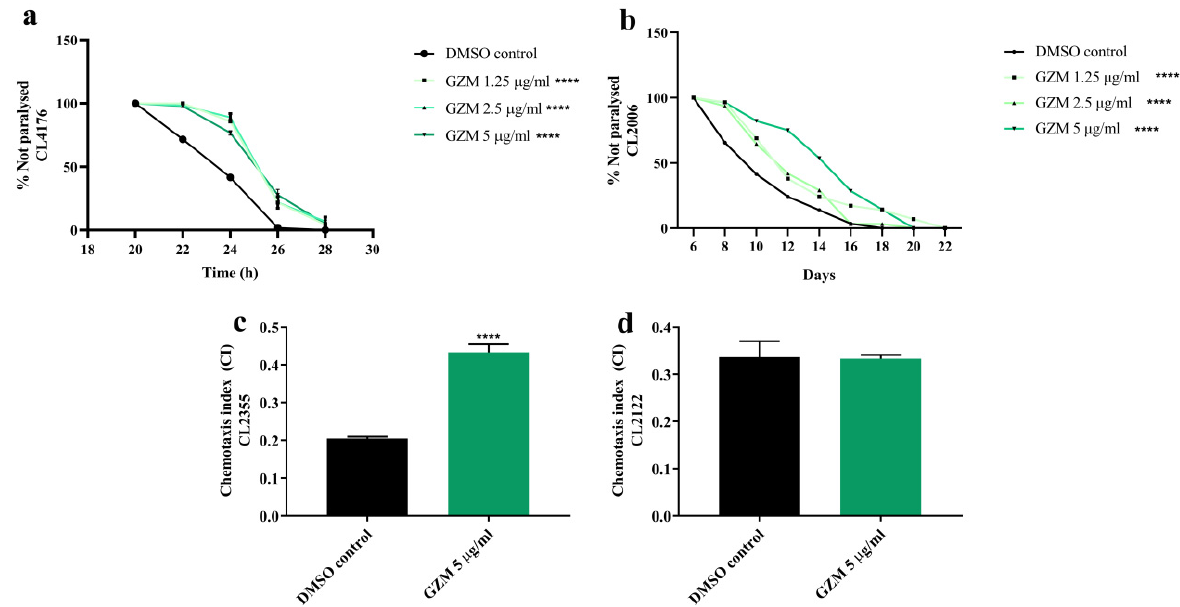
Figure 7. Neuroprotective effect of GZM extract against A β -induced toxicity in C. elegans . GZM extract delayed the progression of body paralysis in CL4176 ( a ) and CL2006 ( b ) worms. GZM extract increased the chemotaxis index in CL2355 ( c ) nematodes. The CL2122 strain serves as control strain ( d ). The represented times are from the instigation of temperature increase. The details of statistical values are provided in Table S8 (Supplementary Materials). ( n = 3); and **** p < 0.0001, DMSO control vs. GZM extract treatment.